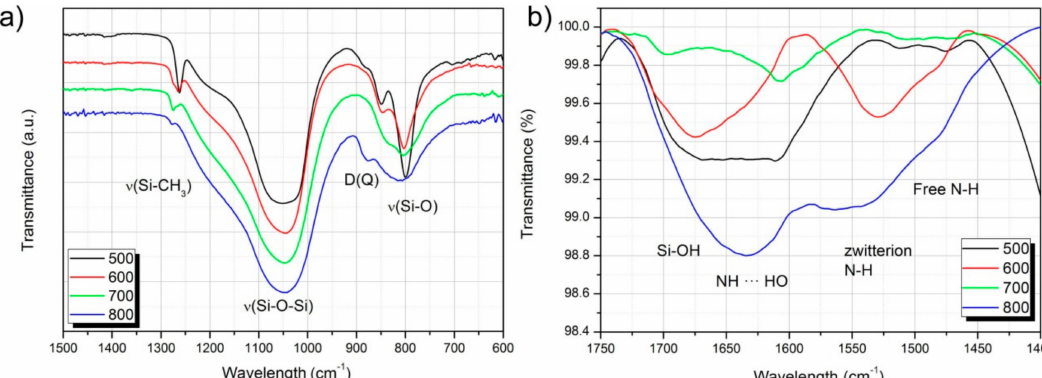
Figure 1. ( a ) FTIR spectra of the materials pyrolyzed at di ff erent temperatures and ( b ) detail of the FTIR-ATR spectra of the materials pyrolyzed at di ff erent temperatures and functionalized with 1% silane in